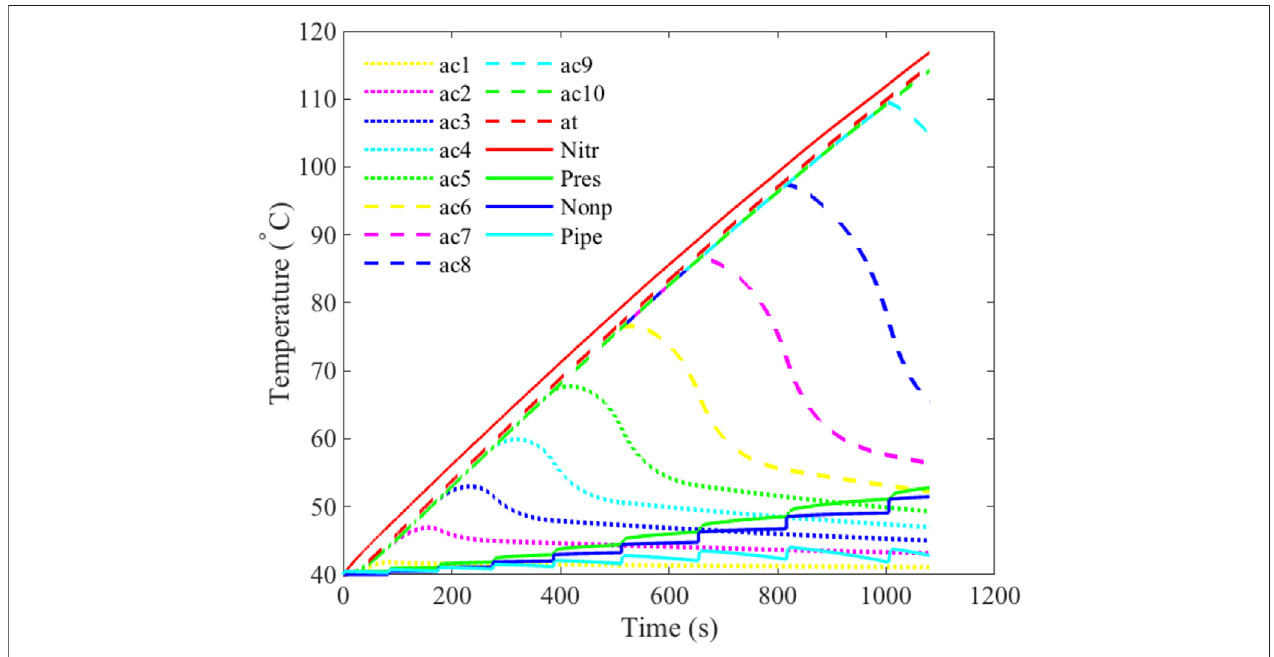
FIGURE 10 | Thermal characteristics of IHESS in the dissipating